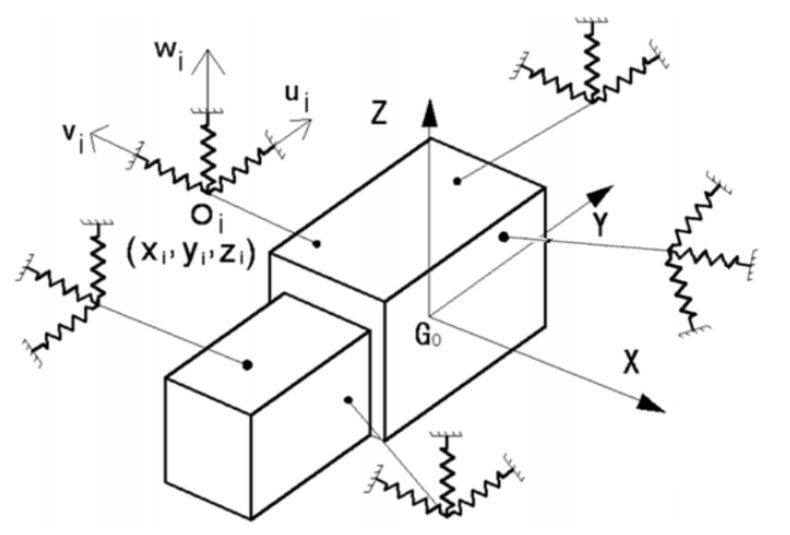
Figure 3. Six-DOF powertrain